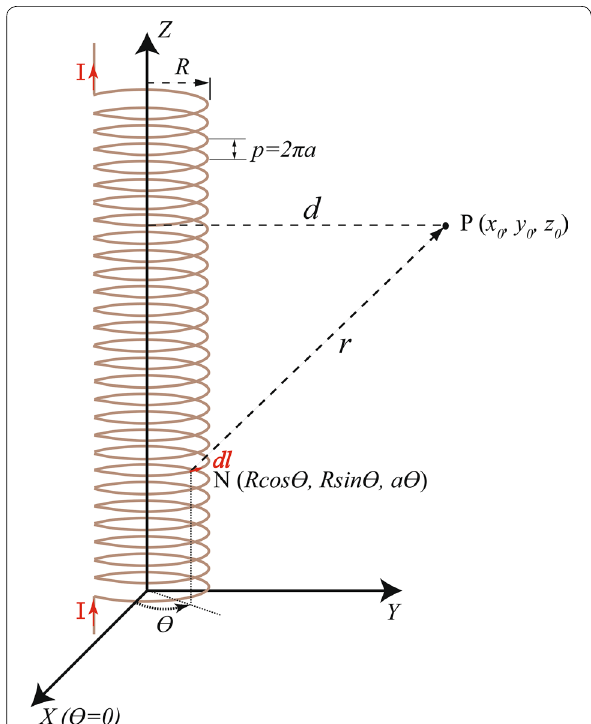
Fig. 2 Schematic diagram for calculating magnetic field outside of solenoid (R is the radius of solenoid, p 2π a is the pitch distance and = d is the distance between point P and central axis of